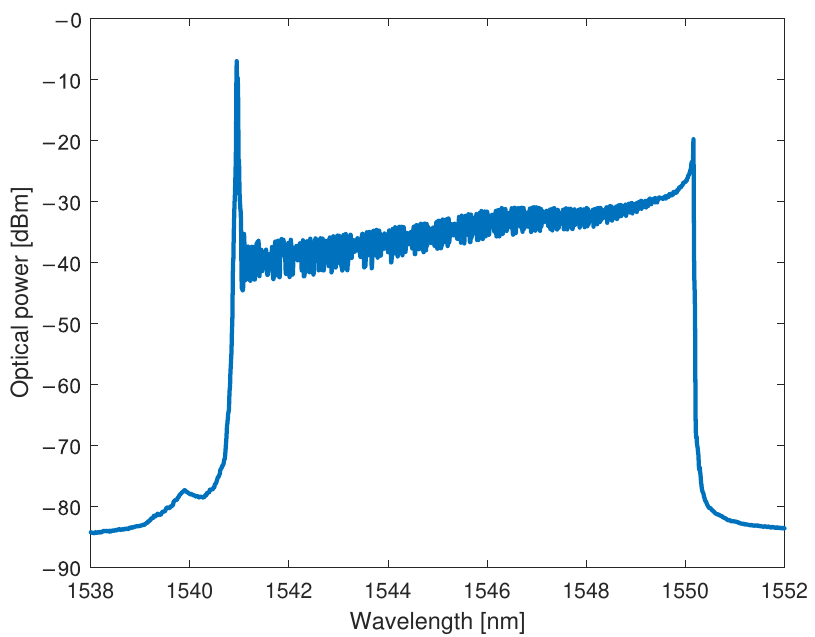
Figure 5. Spectrum of a continuously swept VCSEL-HCG laser. The laser was directly connected to the laboratory-grade OSA, and the measurement was performed with the utilization of long-time integration of the